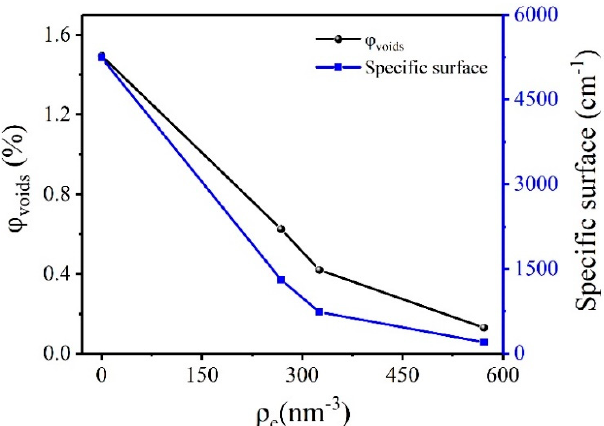
Figure 2. Volume fraction and specific surface of voids in HMX crystals in di ff erent electron density matching solutions.